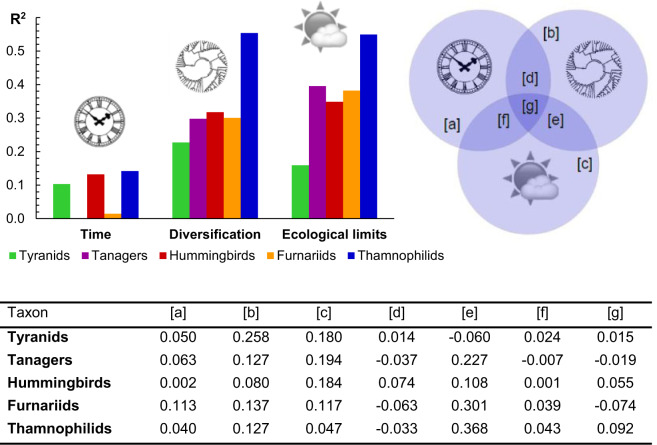
Partitioning the variation in regional richness. The relative effects of time, diversification rates, and ecological limits (top panel) indicate that regional richness is best explained by the effects of climate and productivity (\documentclass[12pt]{minimal}
\usepackage{amsmath}
\usepackage{wasysym}
\usepackage{amsfonts}
\usepackage{amssymb}
\usepackage{amsbsy}
\usepackage{upgreek}
\usepackage{mathrsfs}
\setlength{\oddsidemargin}{-69pt}
\begin{document}
}{}$R^{2} \approx 0.40, P < 0.001$\end{document}). However, detailed results (bottom panel) reveal that the three classes of effects overlap significantly, and each of them makes a unique contribution. The notation in the diagram (top right) corresponds with table columns (bottom), detailing the variation explained by the different combinations of effects.